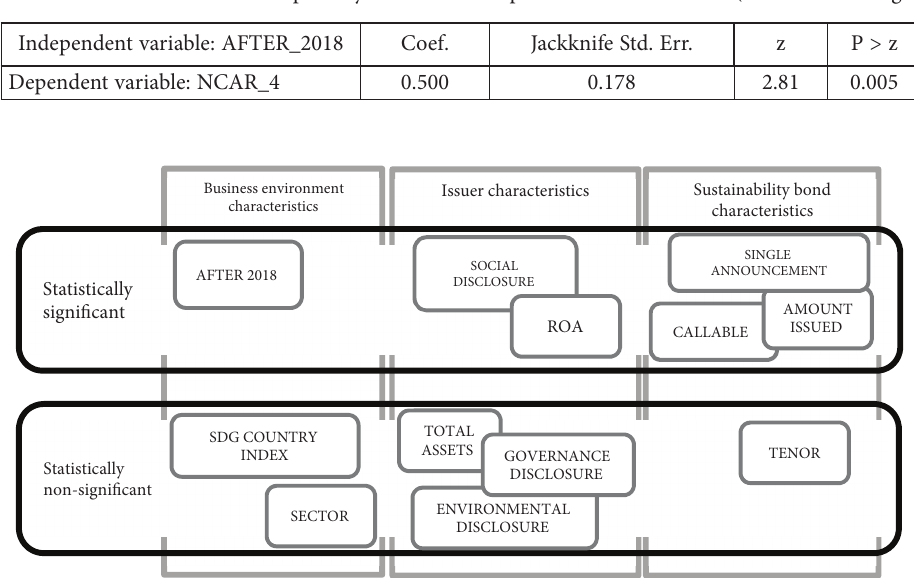
Table 11. Market enhanced transparency – shareholders’ performance association (source: own design)